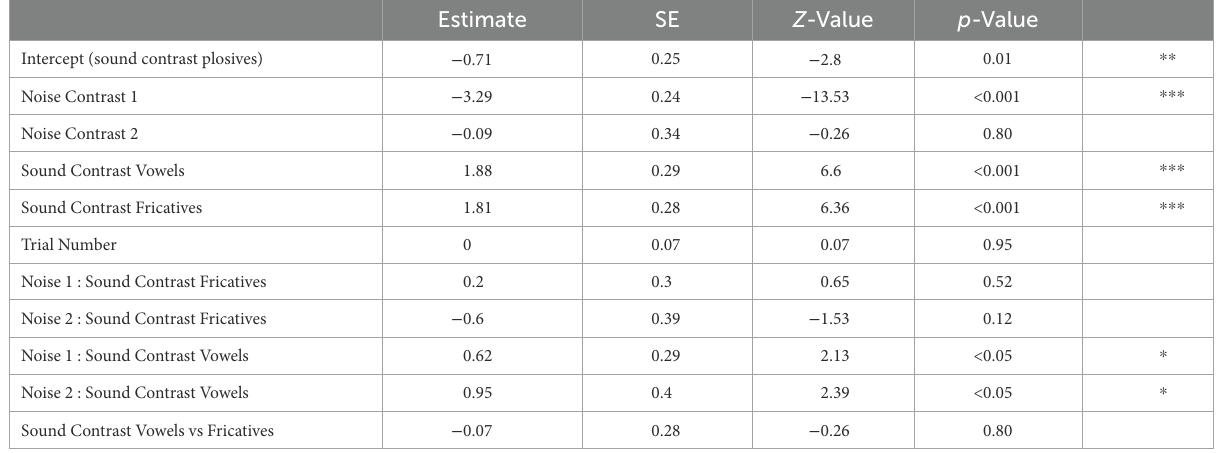
TABLE 3 Model outcomes for the overall model (low predictability